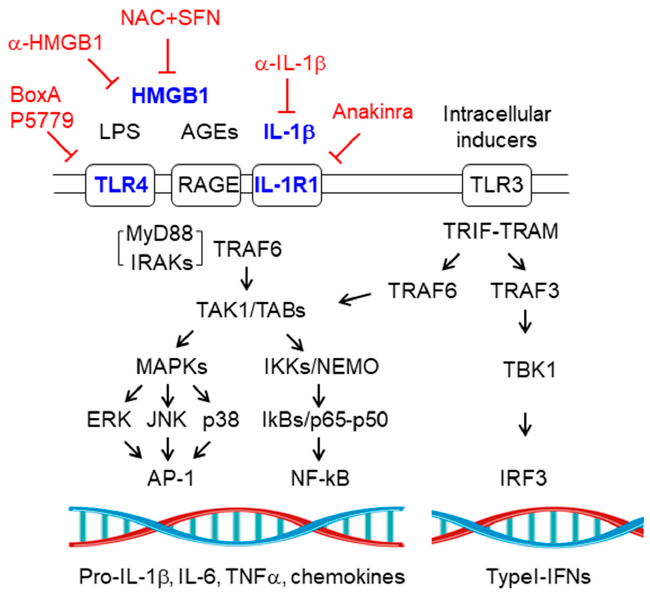
Figure 1. Toll-like receptors (TLRs) signaling pathway. Schematic view of the components of the TLRs signaling pathways. See text for details. TLR4, RAGE, and IL-1R1 are mainly located at the plasma membrane, whereas TLR3 is located in intracellular vesicles. Components of the pathway that are increased in epilepsy are in blue. Therapeutic strategies to prevent the pathway are in red. NAC + SFN: N-acetyl-cysteine plus sulforaphane; α -HMGB1: anti-high mobility group box 1 monoclonal antibody; α -IL-1 β : anti-interleukin-1 β monoclonal antibody. Pointed arrows indicate direction of the signaling pathway. Blunt arrows indicate inhibition.